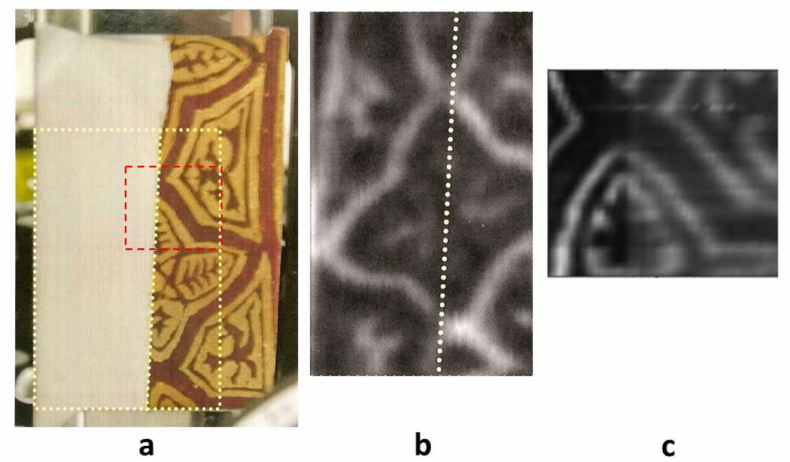
Figure 6. ( a ) Visible image of the mock-up; ( b ) transmission image at 0.6–2.6 THz (yellow dotted area); ( c ) reflection image at 0.15 THz (red dashed area: 50 × 40 mm 2